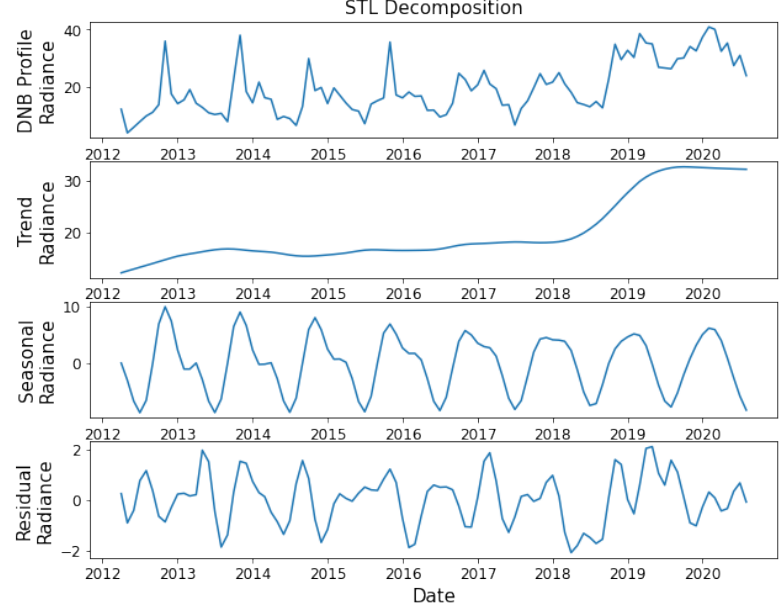
Figure 7. STL of the VNL monthly profile. DNB, Day/Night